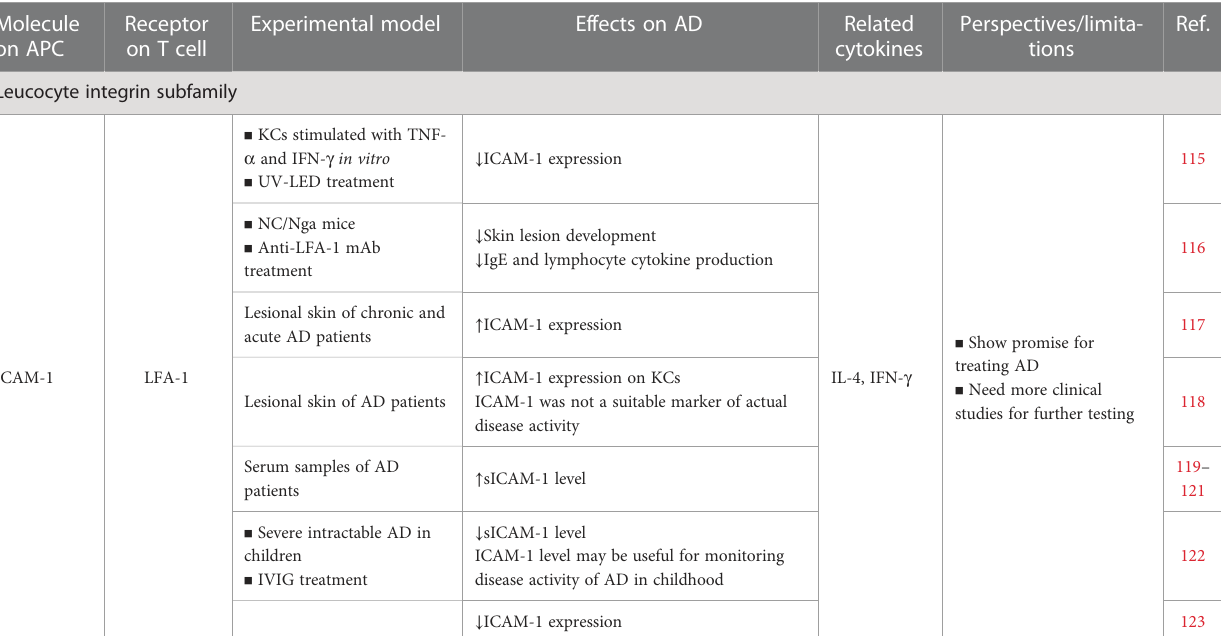
TABLE 3 Preclinical and clinical studies on T cell co-stimulatory and co-inhibitory molecules of the integrin superfamilies. Molecule Receptor Experimental model Effects on AD Related on APC on T cell